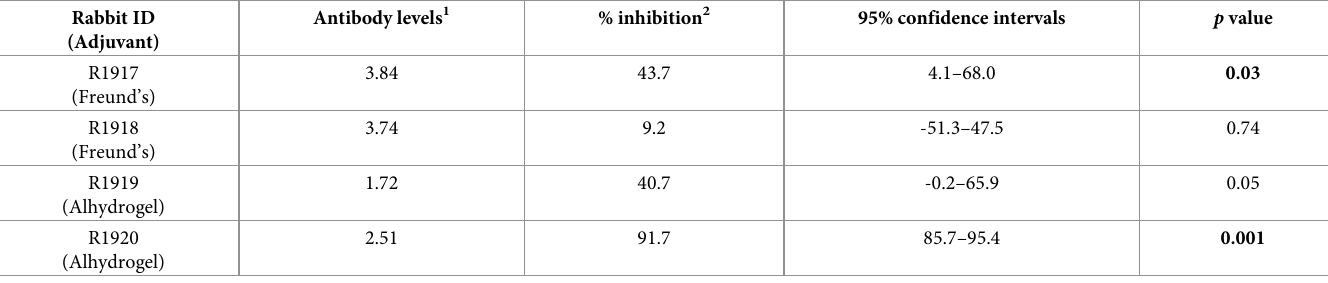
Table 2. Assessment of transmission-blocking activity of rabbit antibodies against Pfs230D1M-dS/dS VLPs by SMFA. Rabbit ID Antibody levels (Adjuvant)